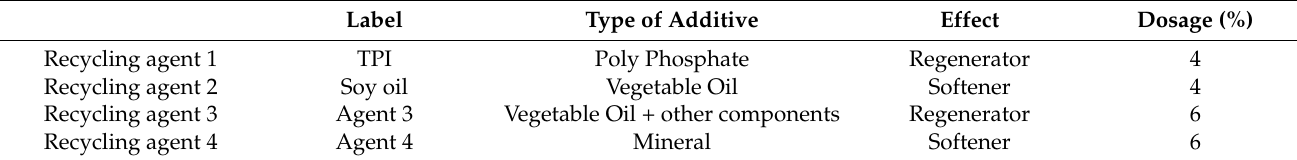
Table 2. Information about the